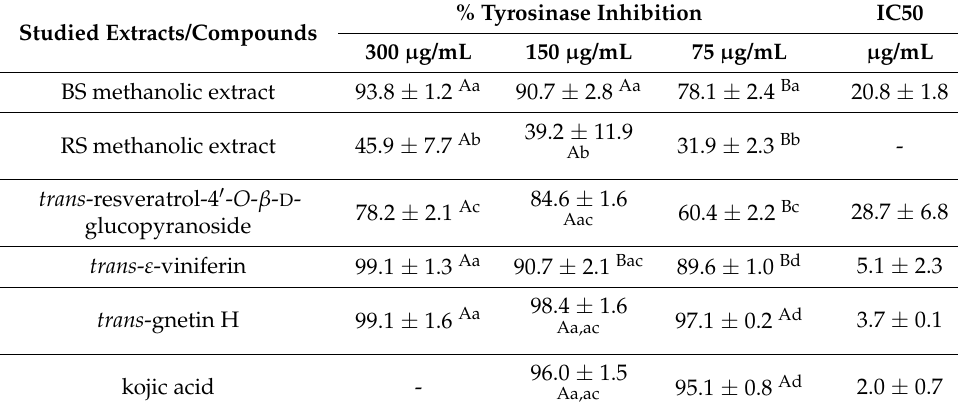
Table 4. Tyrosinase inhibitory activity of BS and RS extracts and isolated compounds at different